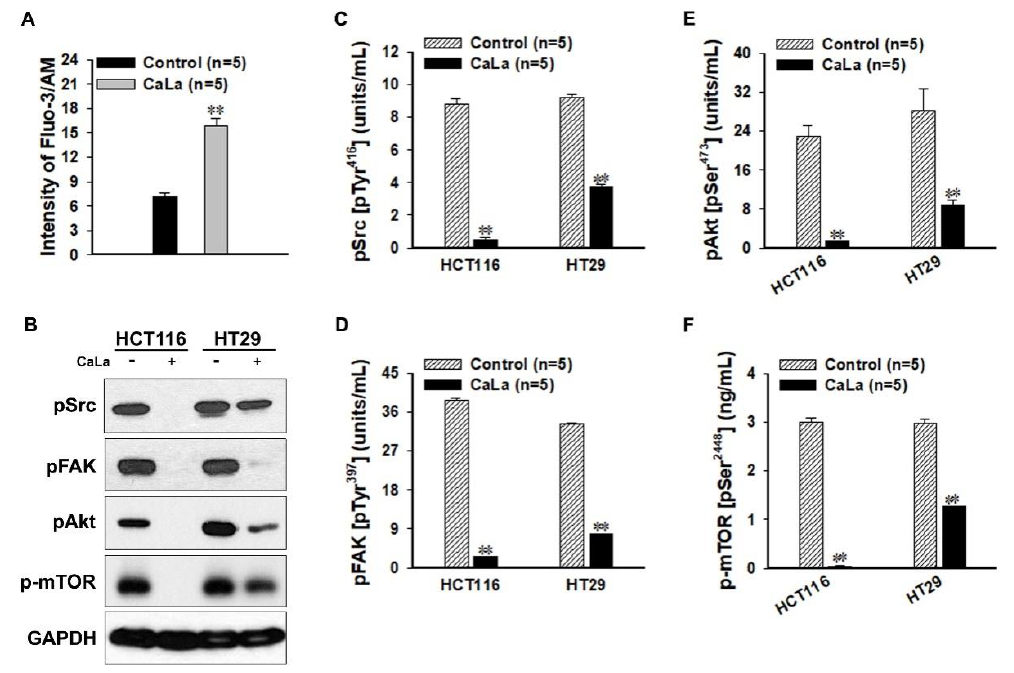
Figure 3. Confirmation of the protein expression of phospho-focal adhesion kinase (pFAK) and the sub-signaling pathways following deactivation of the calcium-dependent steroid receptor coactivator (Src). ( A ) Lactate calcium salt (CaLa)-induced increase in the intracellular calcium influx. ( B ) Immunoblot analysis of pFAK and the sub-signaling pathways in CRC cells. ( C – F ) Enzyme-linked immunosorbent assay (ELISA) assay and quantitative analysis for phospho-(p) Src [pTyr 416 ], pFAK [pTyr 397 ], pAkt [pSer 473 ], and p-mammalian target of rapamycin (mTOR) [pSer 2448 ] sensitivity in CRC cells. ** p < 0.001 vs. Control. Results are mean ± SD.